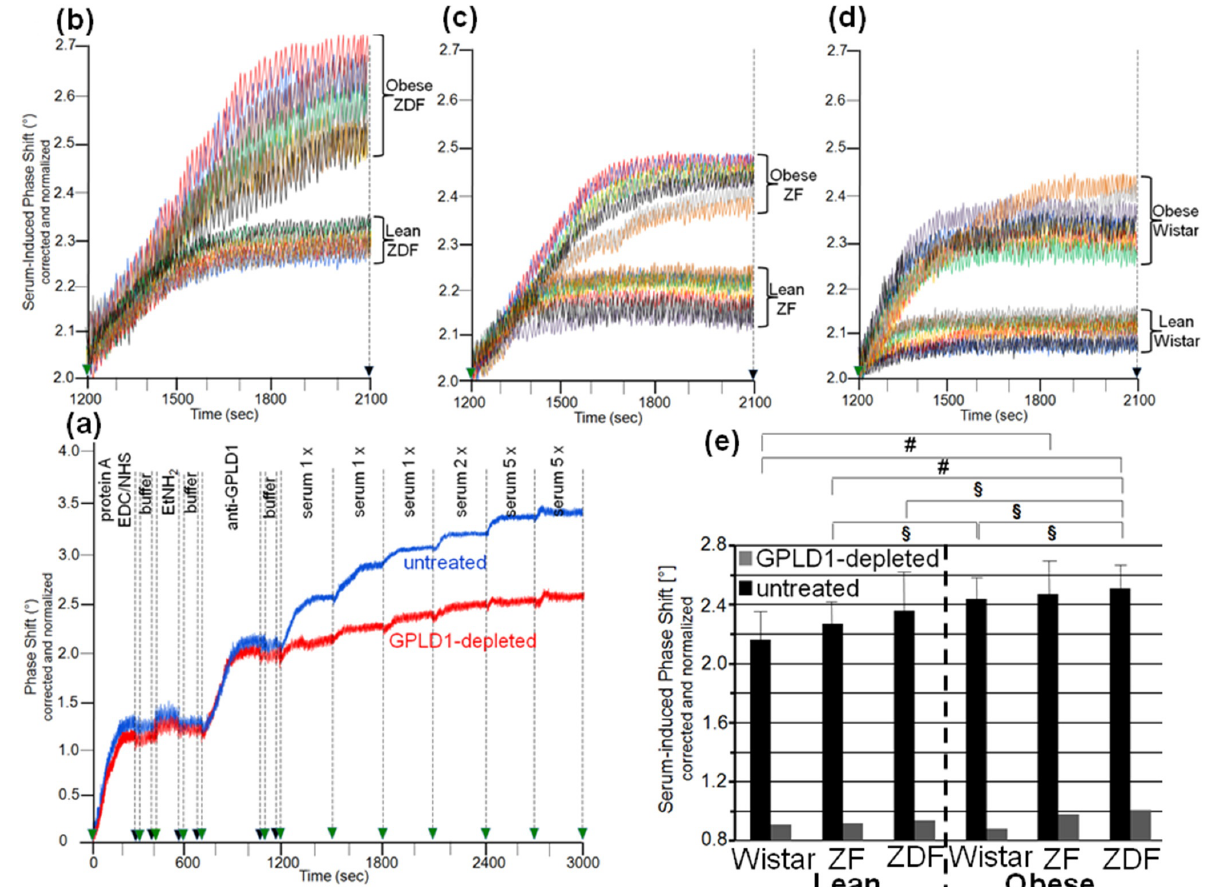
Figure 1. Measurement of the amount of GPLD1 in rat serum using chip-based assay. ( a ) For setup of the assay, first protein A was covalently immobilized onto EDC/NHS-activated chips. Following washing with buffer and blockade of unreacted carboxyl groups by injection of ethanolamine (EtNH 2 ), anti-GPLD1 antibody was injected into the channels. After washing of the chips, single or multiple (as indicated) 100 μ L portions of serum (diluted 10-fold) from obese ZDF rats, which had been depleted of GPLD1 by immune adsorption (red curve) or remained untreated (blue curve), were injected successively. The experiment was repeated once (distinct chip) with similar results (representative shown in a ). The measured phase shift is given upon correction for unspecific interaction of serum components (protein A-coated control channel lacking anti-GPLD1 antibody) and altered viscosity (vs. buffer) of the sample fluid and normalization for the varying responsiveness of distinct chips toward GPI-AP capture. ( b – d ) Identical volumes (single injection of three 100 μ L portions) of sera were injected into chips with bound anti-GPLD1 antibody at time point 1200 s (repeated three times with different chips) with similar results (representatives shown). The phase shift measured as described for ( a ) is shown for the period of serum injection only (serum-induced phase shift: 1200–2100 s). ( e ) The serum-induced phase shift determined in the absence of anti-GPLD1 antibody ( n = 8; means ± SD, quadruplicate measurements, black bars) and its presence ( n = 1; duplicate measurements, grey bars) is given. The comparison between the six rat groups is shown for the sera not subjected to immune adsorption (black bars) only ( # p ≤ 0.02, § p ≤ 0.05).